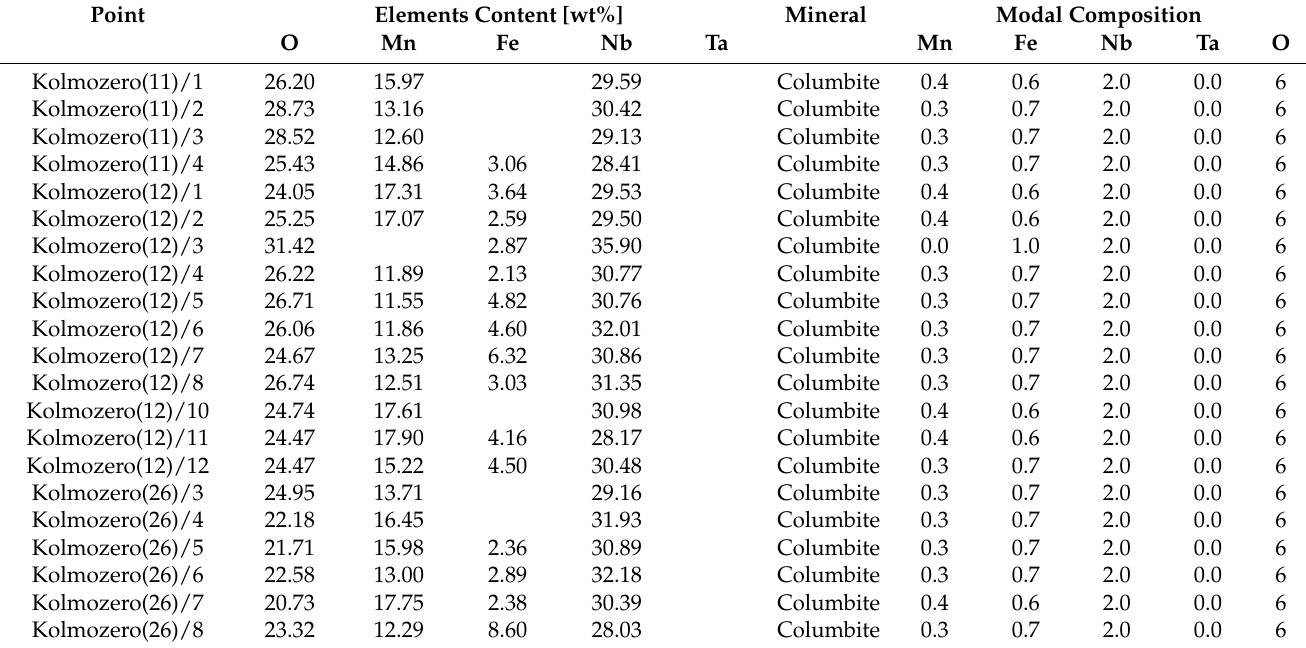
Table A1. SEM-EDS results of the columbite–tantalite crystals and modal composition of these phases based on the proportion of measure